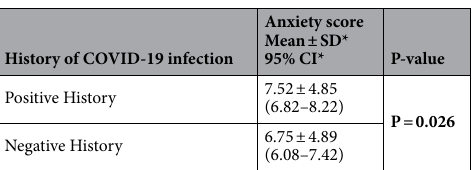
Table 3. The history of COVID-19 infection and anxiety score. *SD = standard deviation, CI = confidence interval for the mean. Significant values are in